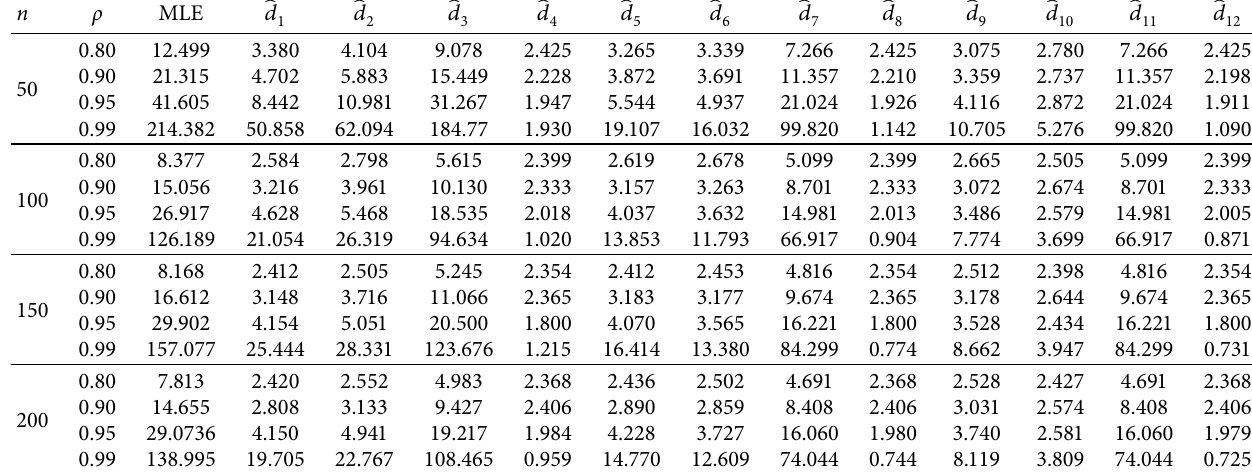
Table 7: Estimated MSEs of the COMPRM estimators, when p � 9 and ϑ � 0 .